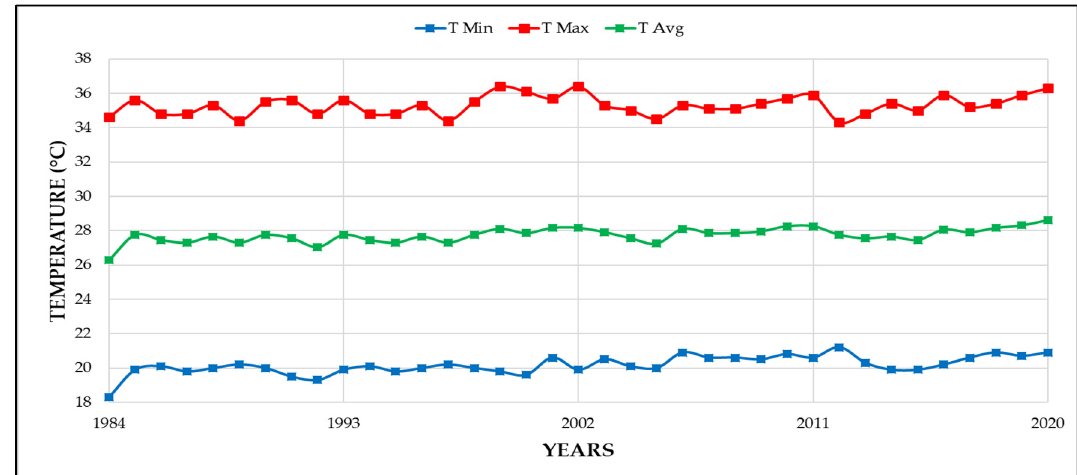
Figure 2. Mean maximum, minimum, and average temperature of the study area from 1984 to 2020. Table 1. Specification of Landsat satellite